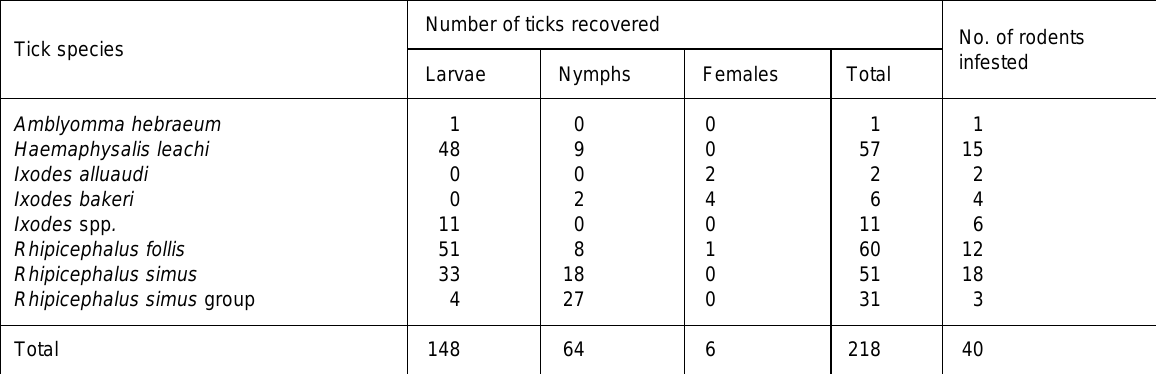
Striped mice as hosts for immature ixodid ticks in Eastern Cape Province TABLE 3 Ticks collected from 73 Otomys spp. in the Gahamstown district